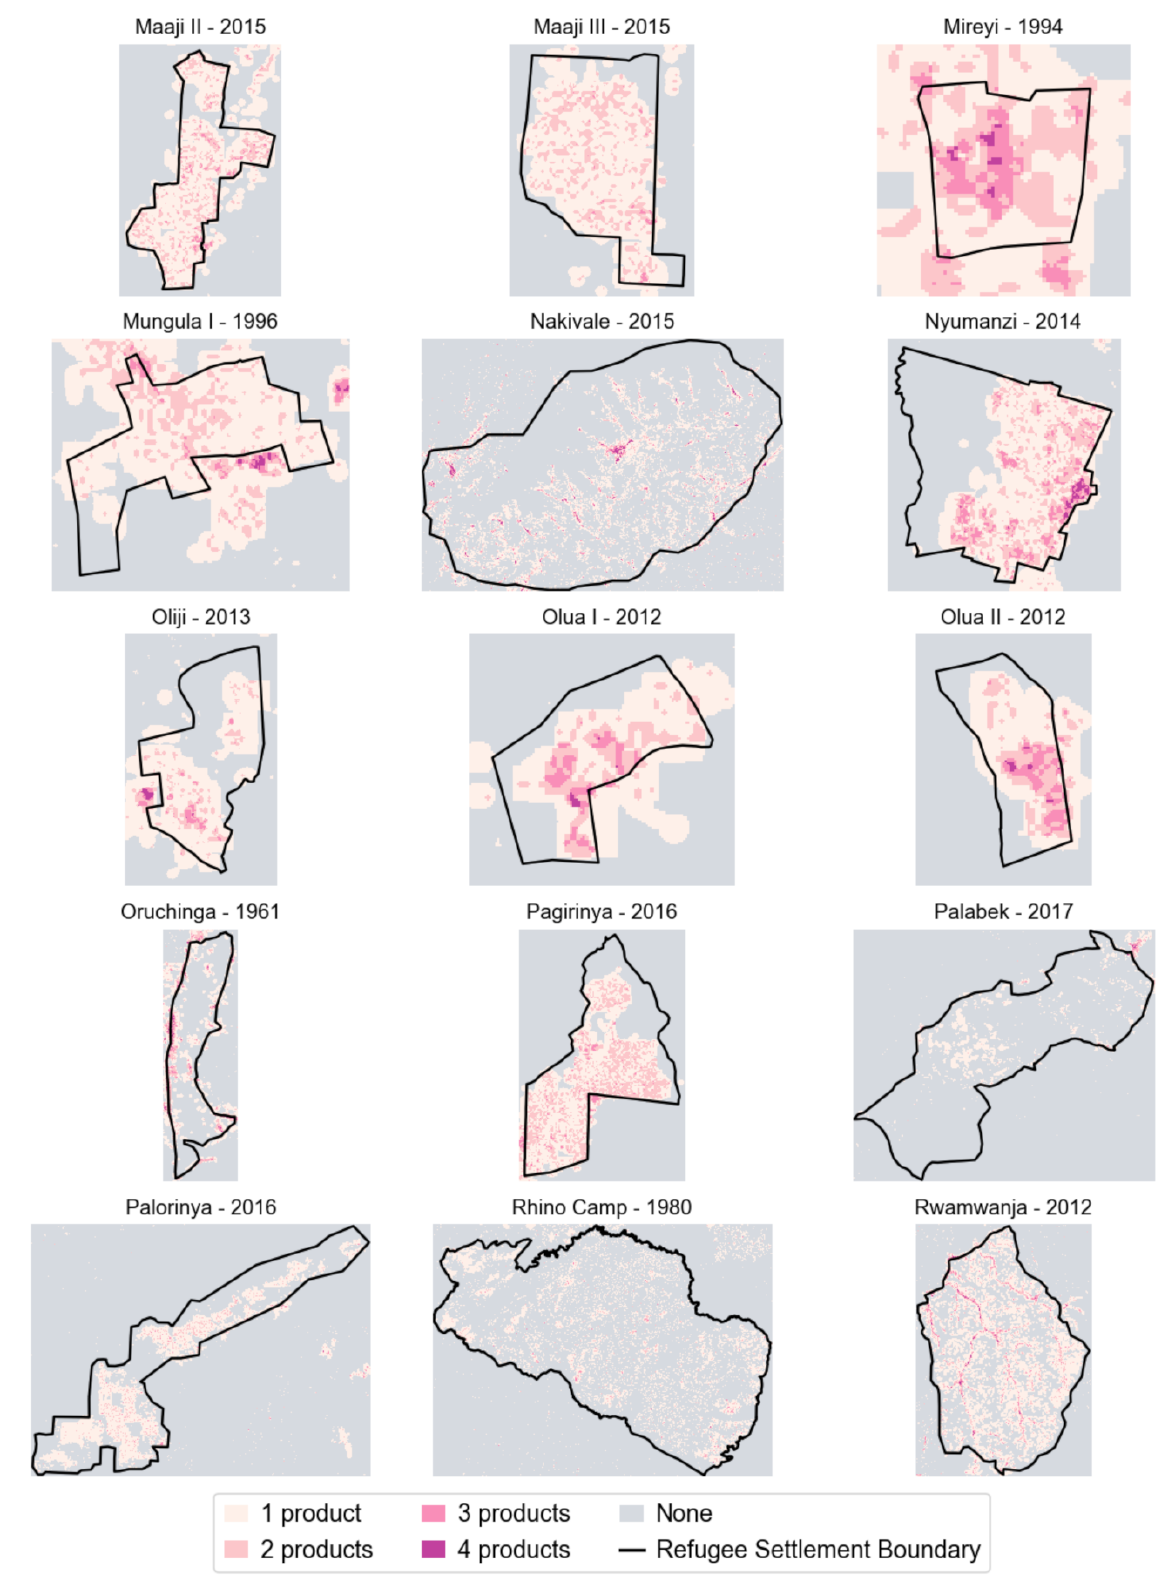
Figure A3. Maps of agreement among four settlement products at refugee settlements: “1 product” indicates unique coverage by a single product; “2 products”, “3 products” and “4 products” indicate the number of settlement products that share coverage; “None” indicates zero coverage. Note that the spatial scale of settlement maps